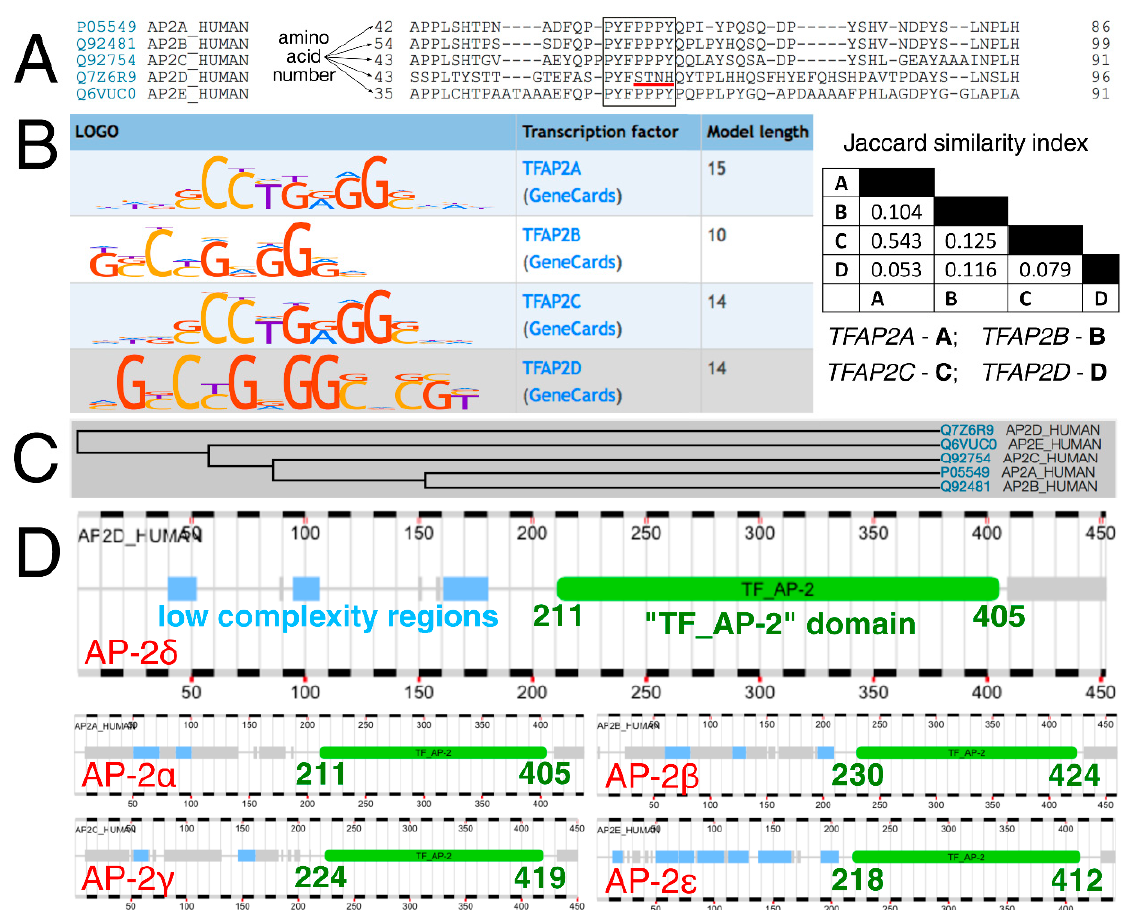
Figure 1. Analysis of AP-2 factors’ sequence, recognizable DNA, evolution, and “TF_AP-2” domain. ( A ) Clustal Omega revealed that the amino acid sequence (encompassing the proline-rich motif in AP-2 members α , β , γ , ε ) is different in AP-2 δ (the core of the pattern is framed; the main difference in AP-2 δ is underlined in red). ( B ) HOCOMOCO identified the consensus logo of AP-2 δ to be similar in length to that of AP-2 α and AP-2 γ , but the sequence itself was congruent to shorter AP-2 β ac- cording to MACRO-APE. ( C ) Phylogeny data acquired from UniProt proved the separate evolution of AP-2 δ compared to other AP-2 proteins. ( D ) The range of the “TF_AP-2” domain among AP-2 members certifies that this part of the protein sequence is highly conserved. This indicates that the distinction of AP-2 proteins is supposedly due to differences located in the “first half” of the